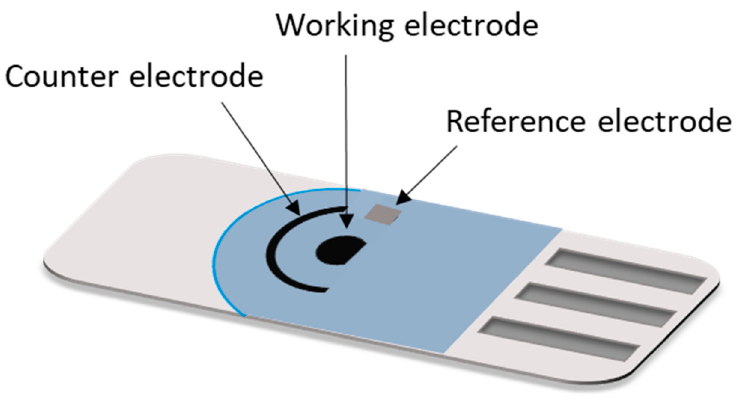
Figure 3. Design of an easy-to-use, disposable and portable SPCE [52,54].